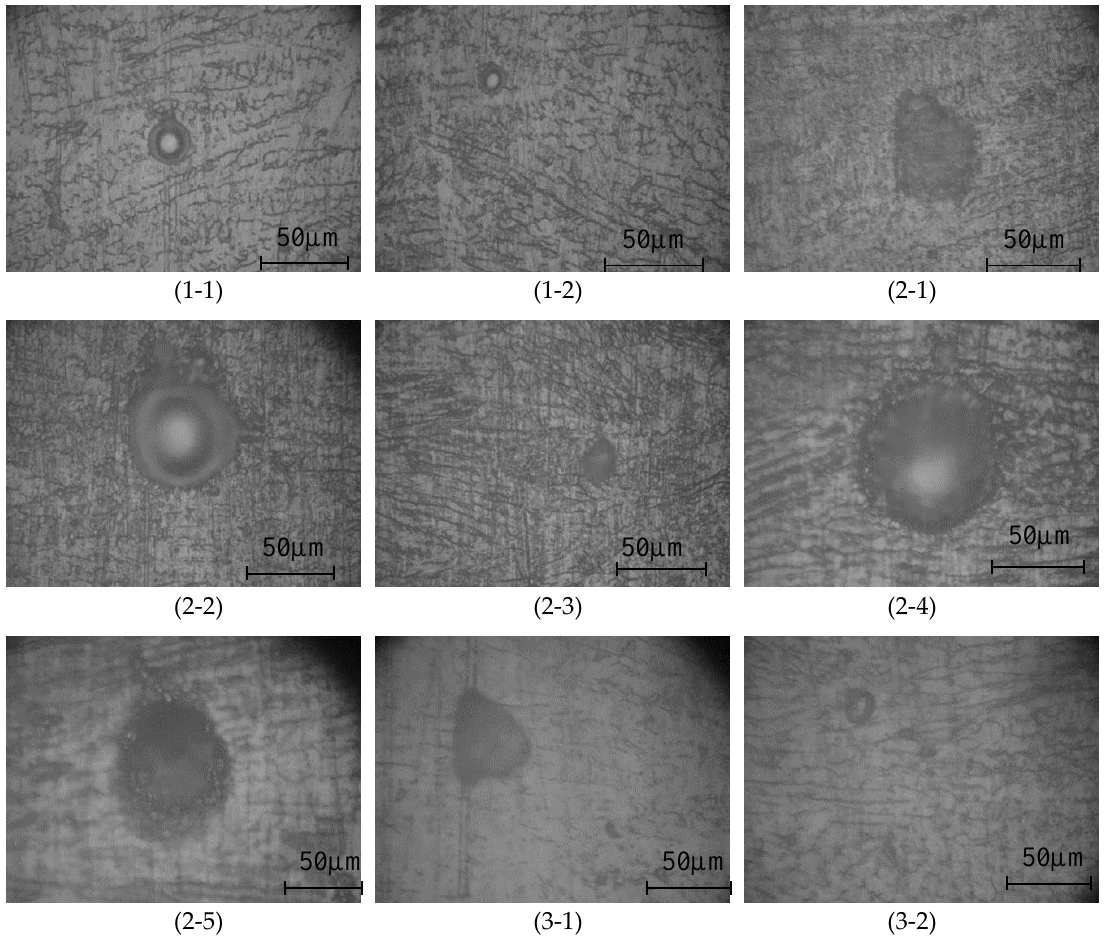
Figure 6. The pores in the cross section of the welded seam. The captions of each image were named as i - j , which meant the j -th pores in the i -th cross sections.